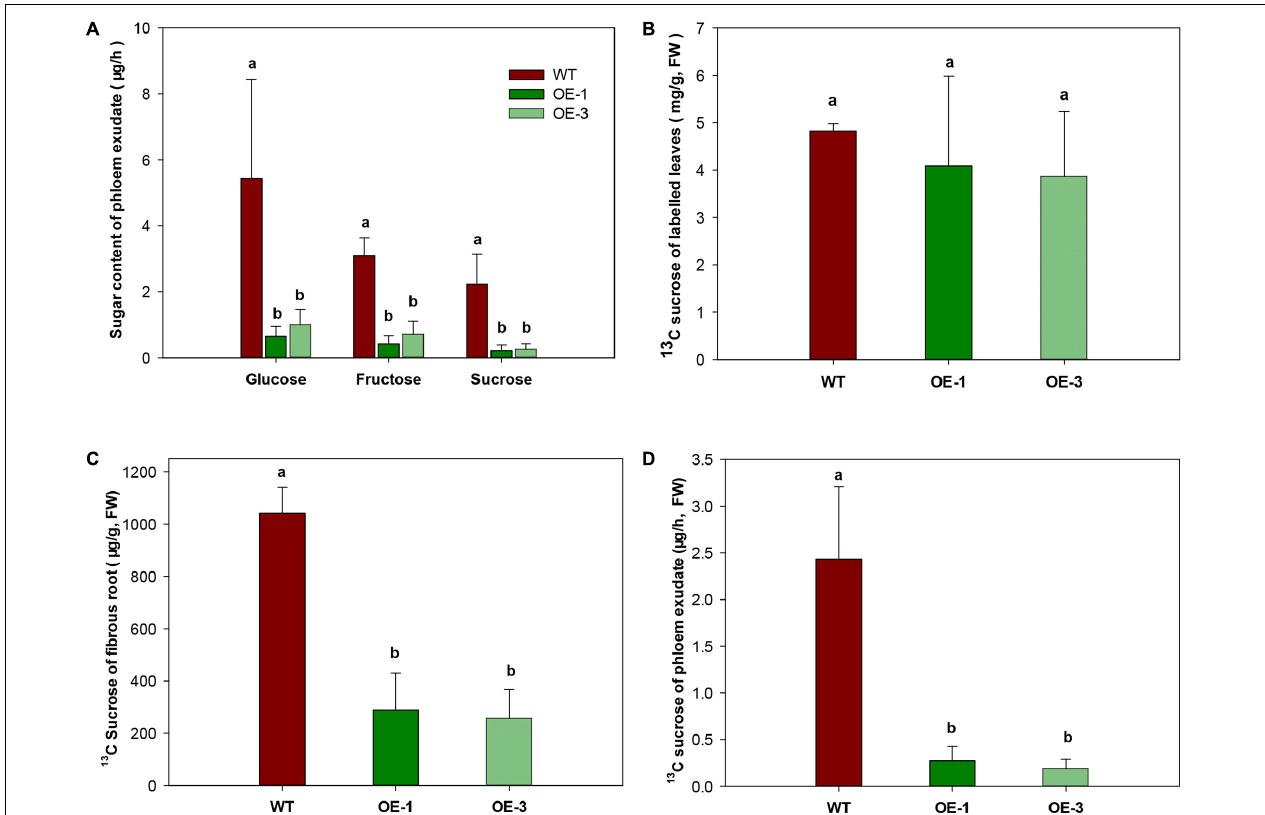
FIGURE 7 | Sugar transport capacity in wild-type (WT) and the MeCWINV3 -overexpressed (OE) cassava plants. (A) Contents of glucose, fructose, and sucrose in phloem exudates. (B) Content of 13 C-labeled sucrose in leaves of 13 CO 2 -fed plants. (C) Content of 13 C-labeled sucrose in fibrous roots of 13 CO 2 -fed plants. (D) Content of 13 C-labeled sucrose in phloem exudates of 13 CO 2 -fed plants. Different letters indicate significant differences (one-way ANOVA, p < 0.05).